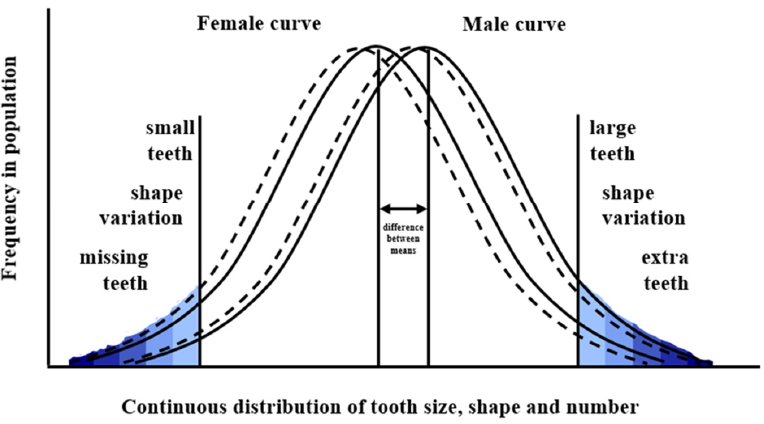
Figure 7. Model of the normal distribution of tooth number, size and shape with thresholds beyond which clinically relevant variations occur. The variation in the shading reflects the increasing severity as the tails of the distribution are approached. The dotted curves are for female and male Romano-Britons., showing smaller teeth probably related to severe environmental insults [11].